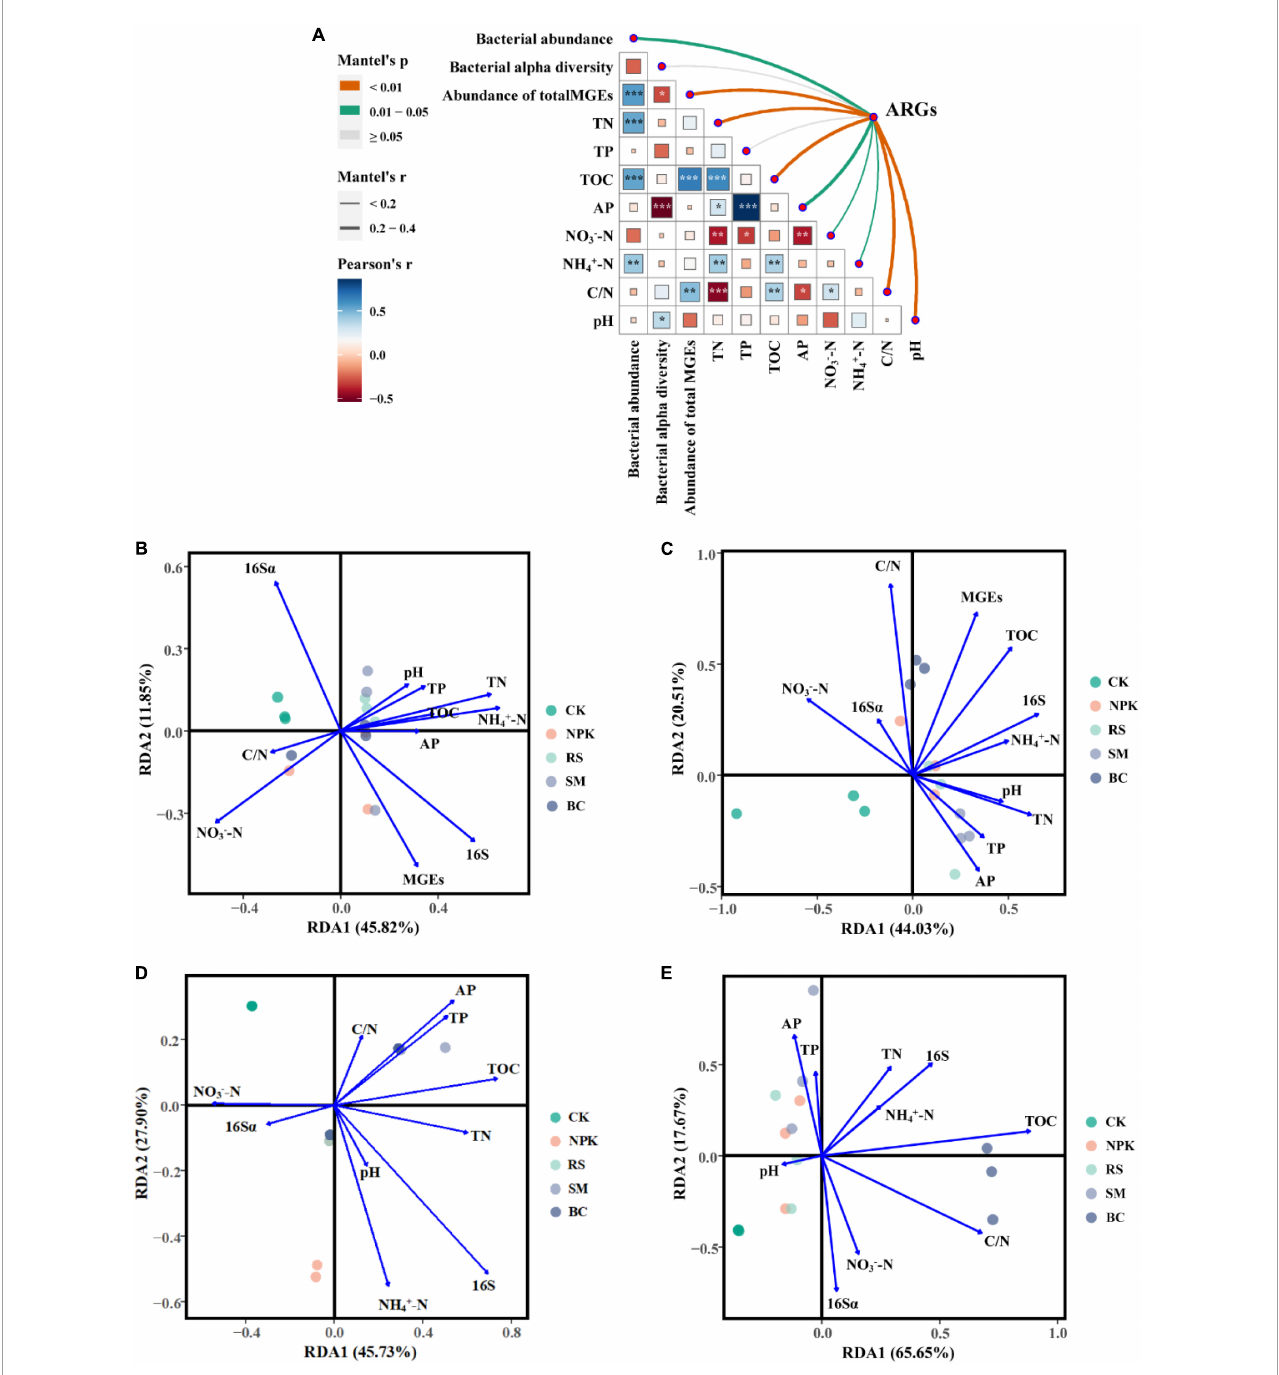
FIGURE6 Pairwise comparisons of environmental factors (soil properties, bacteria, and MGEs) are shown, with a color gradient denoting Pearson’s correlation coefficient (A) . The composition of ARGs was related to each environmental factor by Mantel tests. Edge width corresponds to the Mantel’s r statistic for the corresponding distance correlations, and edge color denotes the statistical significance based on 999 permutations. Redundancy analysis (RDA) of the effects of environmental factors on detected number (B) and ARGs abundance (C) across all treatments, and the effects of environmental factors on MGEs detected number (D) and abundance (E) across all treatments. In all figures, C/N means the ratio of soil total carbon and total nitrogen, TOC means soil total carbon, TN means soil total nitrogen, TP means soil total phosphorus, AP means soil available phosphorus, NO 3 – -N means soil nitrate nitrogen content, and NH 4 + -N means soil ammonium nitrogen content. (B–E) The 16S means the bacterial abundance, and the 16S α means the bacterial alpha diversity (Shannon-Winner